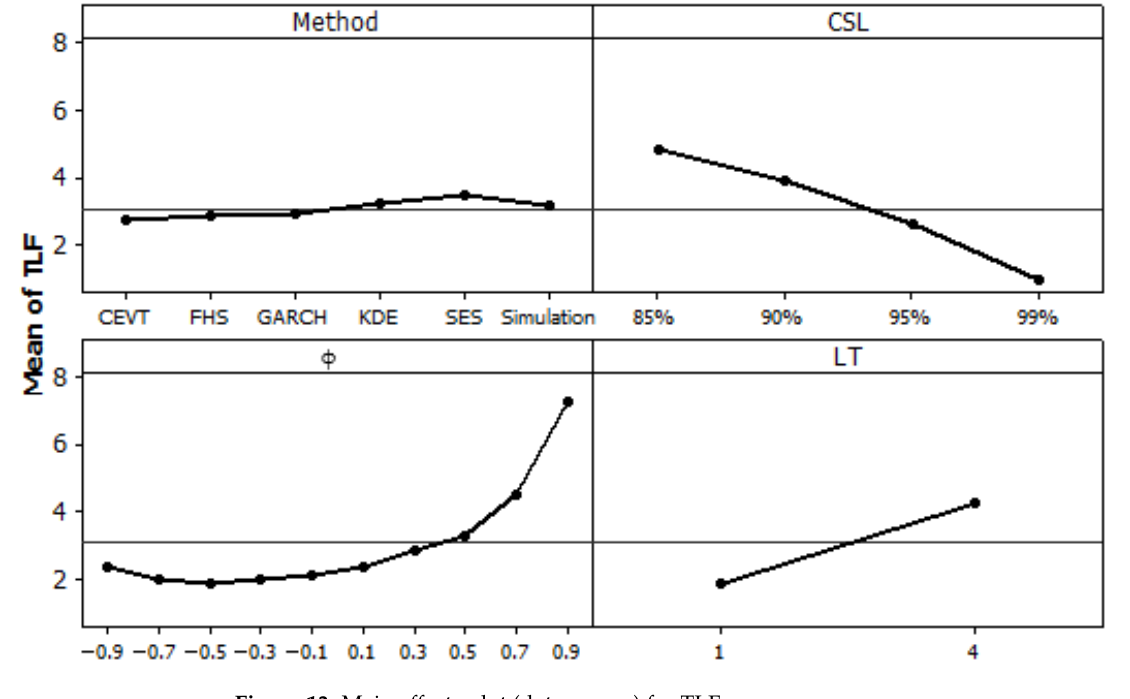
Figure 13. Main effects plot (data means) for TLF.